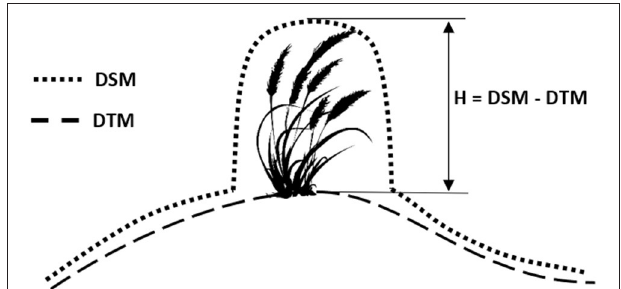
FIGURE 4 | Schematic workflow used to estimate crop height. Digital terrain model (DTM) and digital surface model (DSM) obtained through automatic aerial triangulation. Plant height (H) estimated above ground